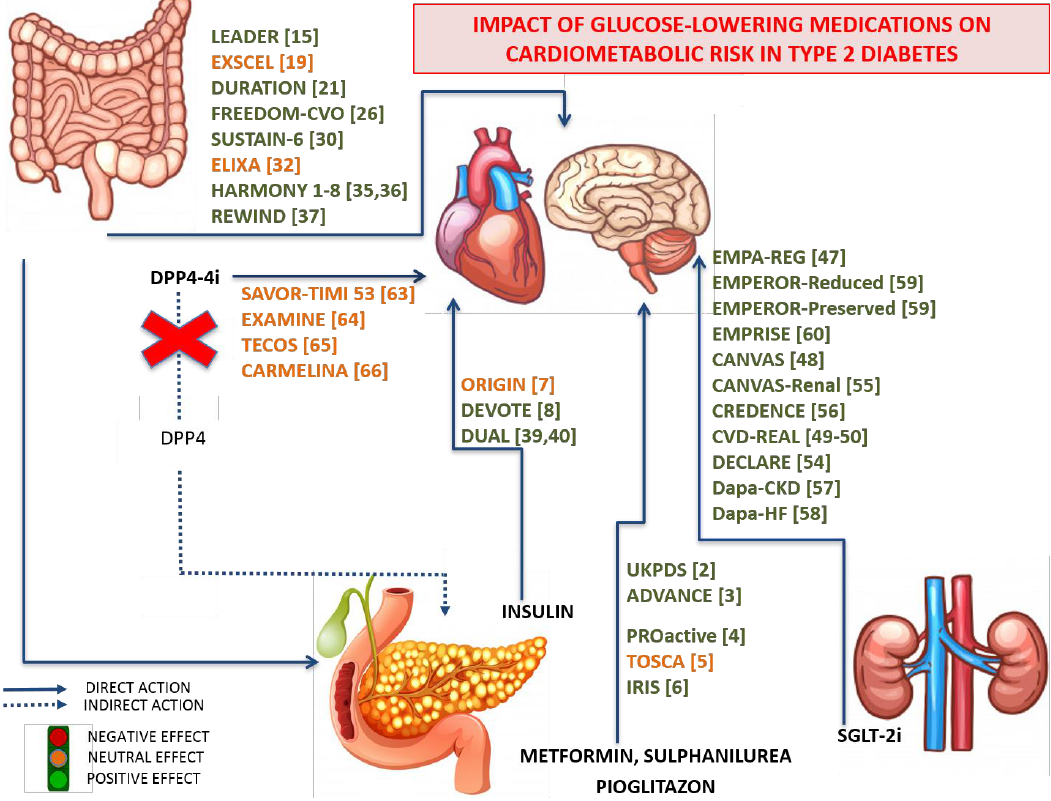
Figure 1. Schematic representation of the main routes, tissue biotargets, mode of actions, and e ff ects of glucose-lowering medications, and their impact on cardiovascular risk in patients with Type 2 Diabetes. The data are obtained from both scientific literature and CardioVascular Outcome Trials, carefully assessing the cardiovascular safety of the main newest glucose-lowering medications.